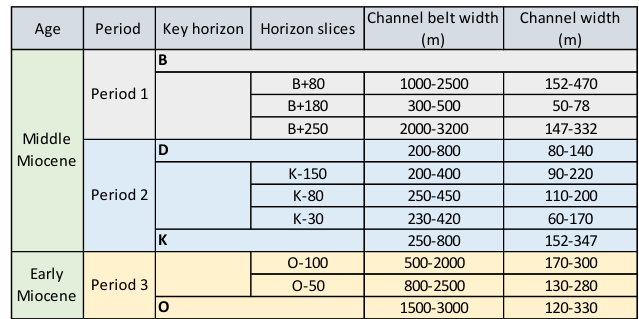
Table 1: Summary of the channel belt and abandoned channel width in the zone of interest